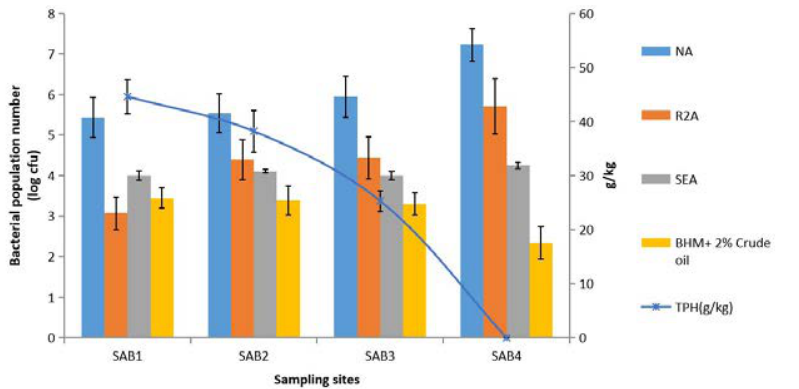
Fig. 1. Variation in bacterial population number (log cfu) when different culture media were used for isolation along with the level of TPH content in the studied Table 2. Screening of bacterial isolates for hydrocarbon degradation abilities and biosurfactant production (‘+++’ maximum growth; ‘++’ average growth; ‘+’ slow growth; ‘-’ no growth ) Bacterial